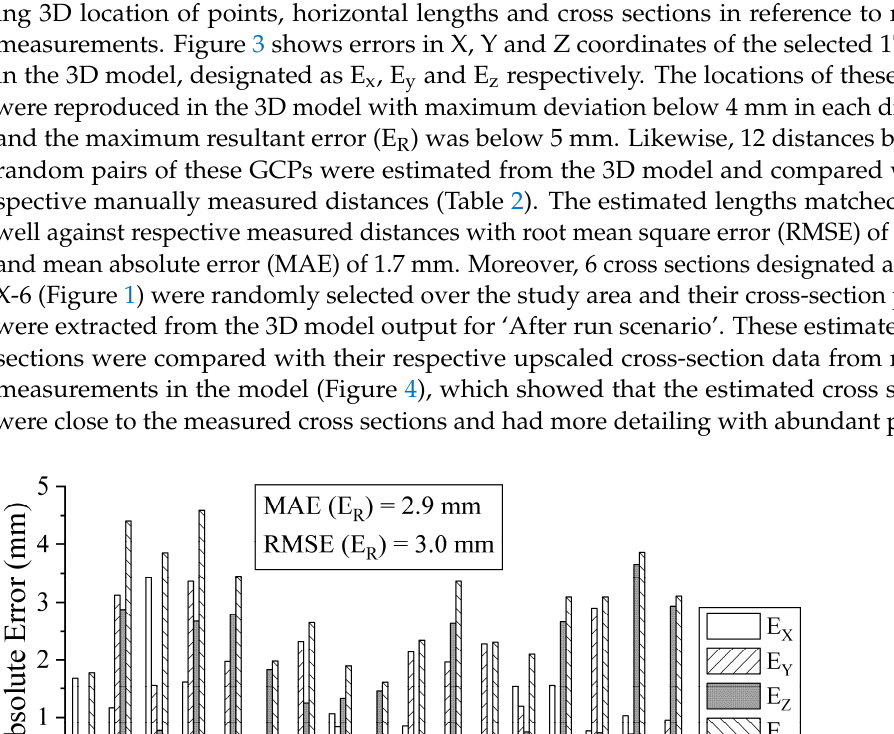
Figure 2. DEMs produced by SfM technique for Case Study I: ( a ) initial mobile bed; ( b ) final bed after test run.